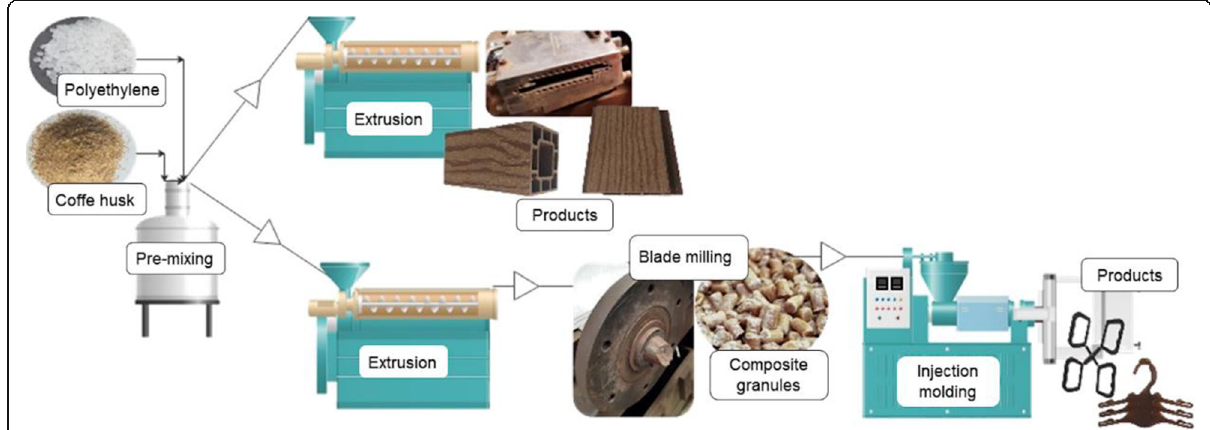
Fig. 7 Extrusion and injection molding processes for eco-composites